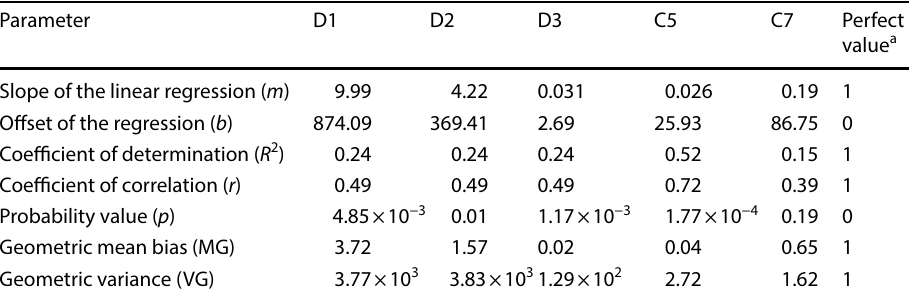
a Value of parameter, when the measured and modelled concentrations are the same in all